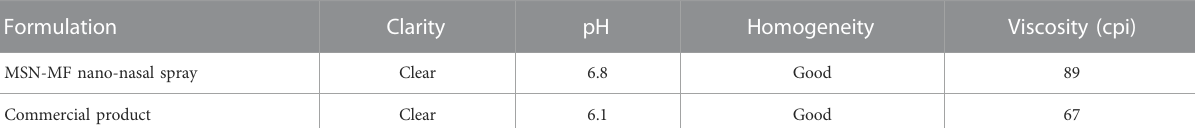
TABLE 3 MSN-MF nano-nasal spray comparison with